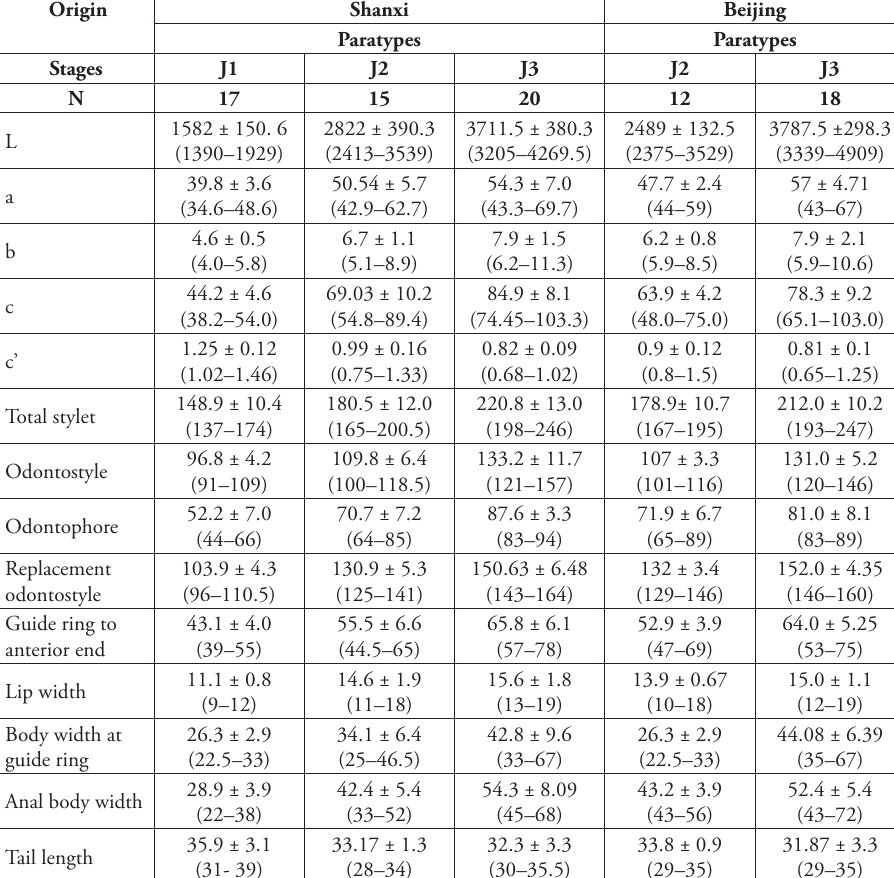
Table 2. Measurements (in μm and in the form, mean ± standard deviation and range) of juvenile stages of Longidorus cheni sp. n. from two provinces in